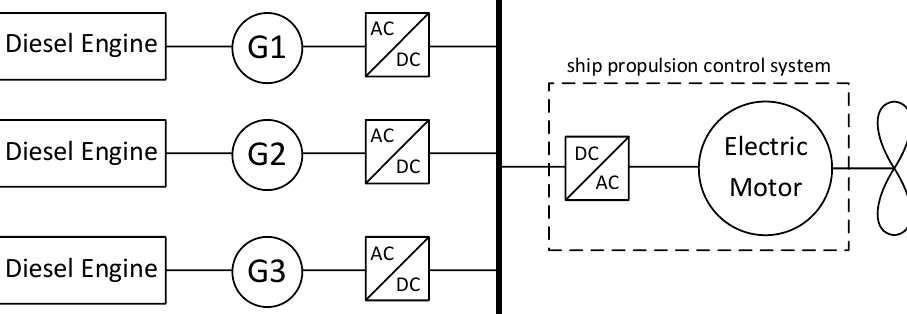
Figure 2. Ship propulsion system in the diesel – electric system with optimization of the operation of generator propulsion engines (DC grid).